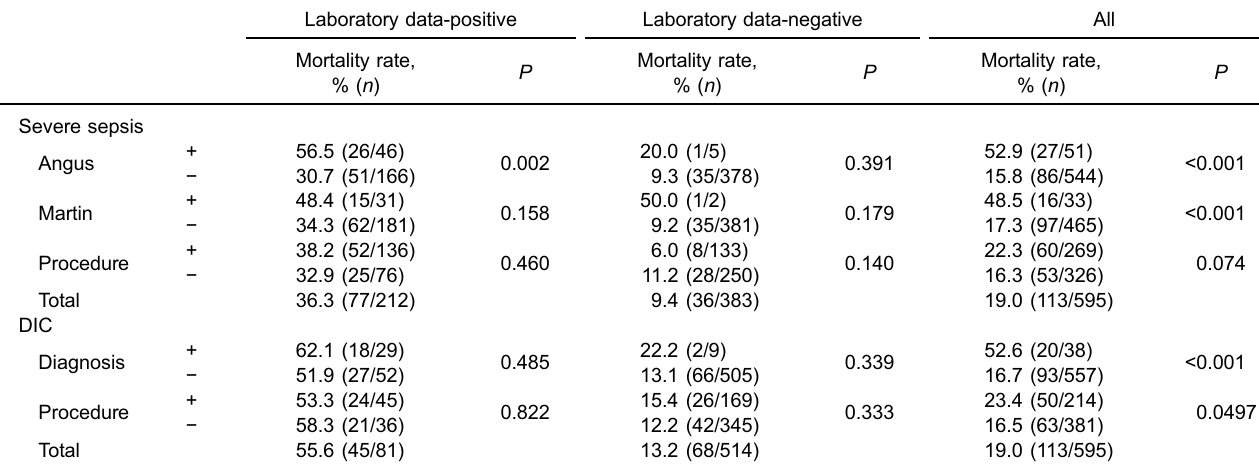
Table 5. Comparisons of mortality rates Laboratory data-positive